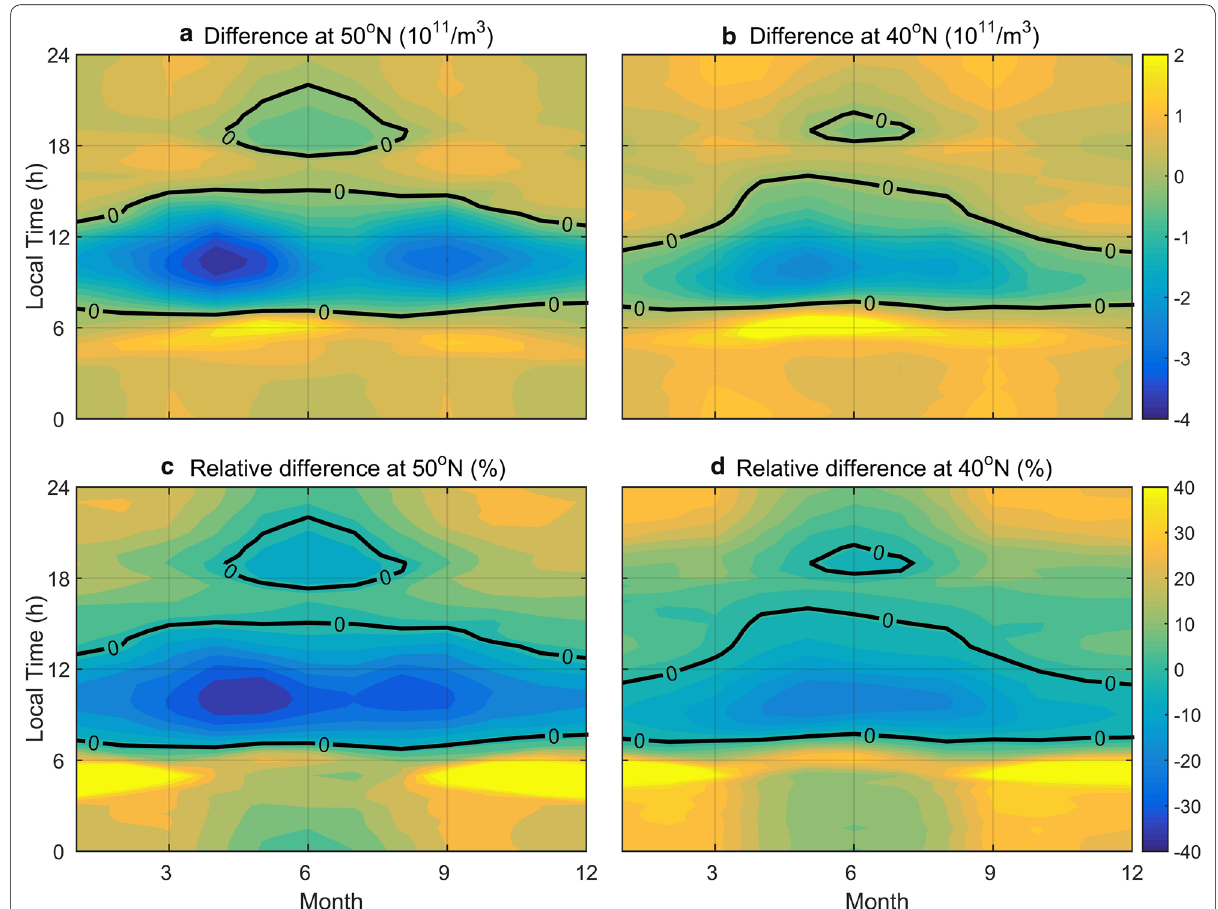
Fig. 6 The latitude variations of NmF2 east–west differences. The top and bottom plots, respectively, show the seasonal and diurnal variations of ΔNmF2 ( a , b , in units of 10 11 /m 3 ) and R ew ( c , d , in units of %). The left and right plots, respectively, show the east–west differences ( a , c ) at 50º N and ( b , d ) at 40º N. The solid lines in these plots represent the zero